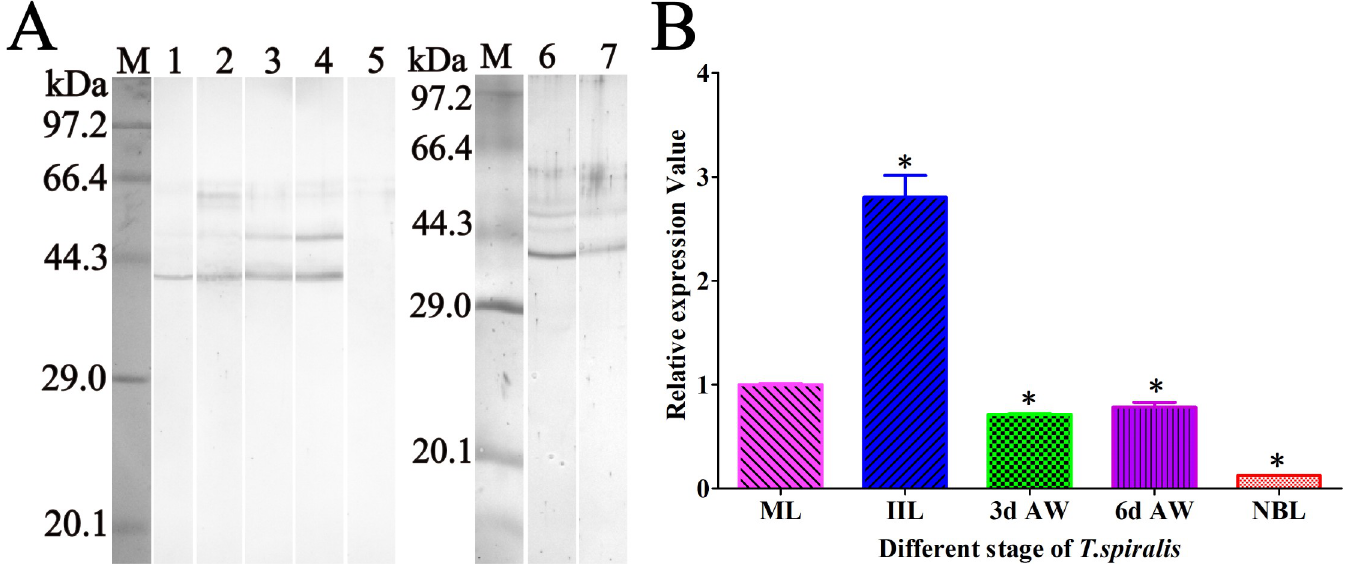
Fig 2. Western blot (A) and qPCR (B) analysis of TsASP2 protein and mRNA expression in different T . spiralis stages. A: Anti-rTsASP2 serum recognized native TsASP2 in different T . spiralis stage crude proteins, including ML (lane 1), 6-h IIL (lane 2), 3-d AW (lane 3), 6-d AW (lane 4), but not NBL (lane 5), and ML ES (lane 6) and IIL ES (lane 7). B: The TsASP2 mRNA expression levels in different T . spiralis stages were assessed by qPCR. Asterisks indicate a statistically significant difference compared with the ML stage ( � P <